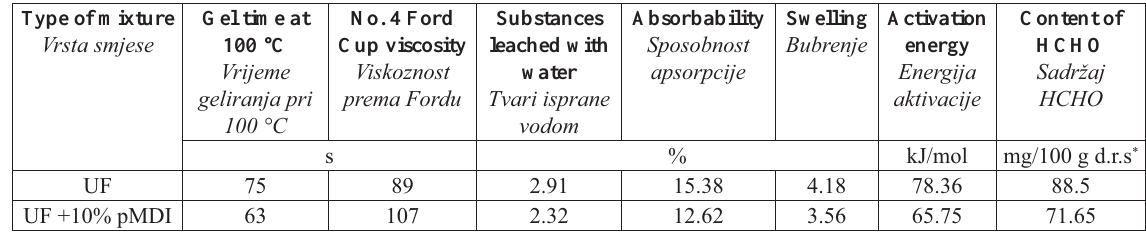
Table 2 Properties of UF/pMDI adhesive mixture Tablica 2 . Svojstva smjese ljepila UF/pMDI